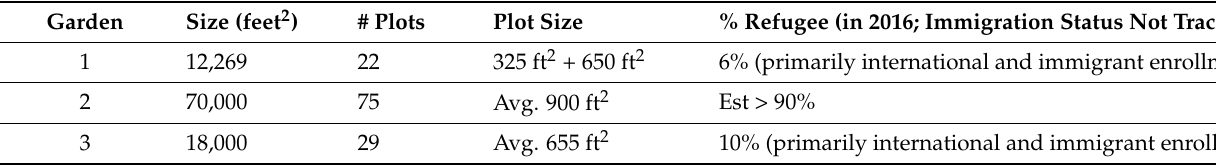
Table 1. Study garden size, plot details, and refugee